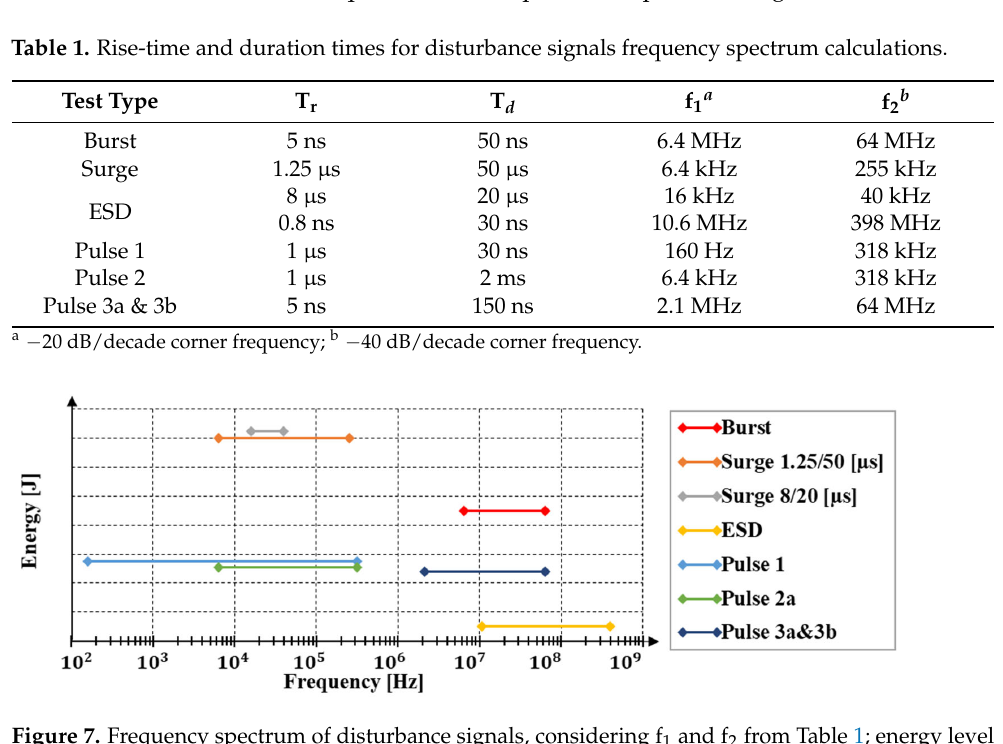
Figure 7. Frequency spectrum of disturbance signals, considering f 1 and f 2 from Table 1; energy level is reported qualitatively.